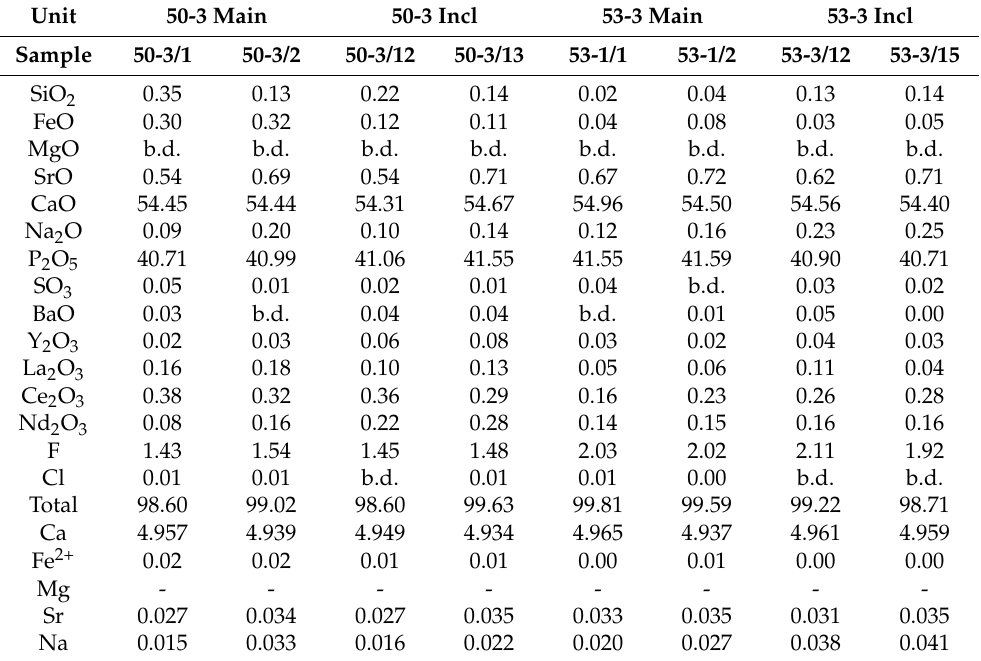
Figure 4. Variation of magnetite compositions from Arbrastakh phoscorites ( a ) Al, ( b ) Ti versus Mg. Table 2. Representative compositions of apatite from phoscorites of the Arbarastakh massif. B.d. = be- low the detection limit. The structural formulae of apatite are calculated for eight cations (in table